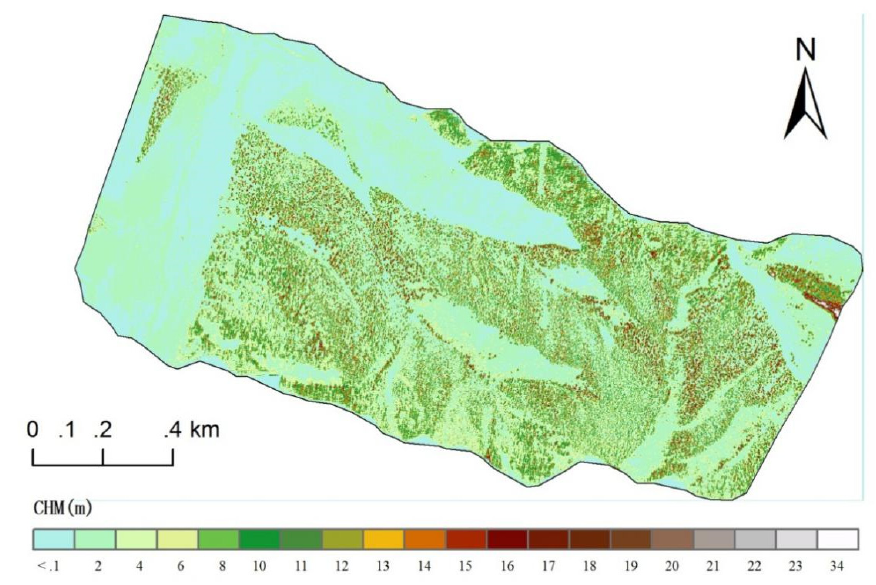
Figure 5. The canopy height model (CHM) of the study area.